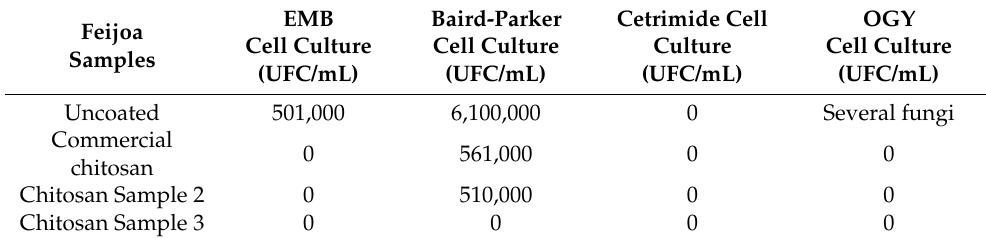
Table 4. Microbial counting at day 15 for different chitosan biofilm sources.